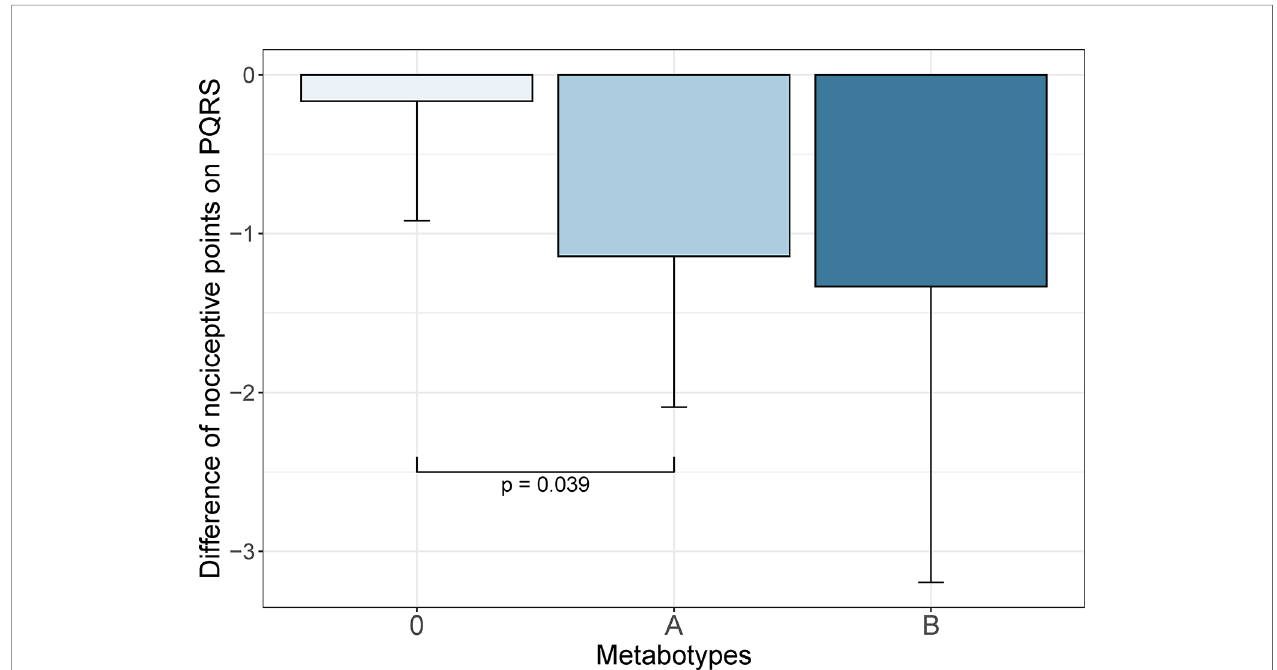
FIGURE 5 | Decline of the nociceptive score points during the post-operative recovery of 26 patients who both completed the Post-operative Quality Recovery Scale (PQRS; [26]) questionnaire and blood samples were available. Based on urolithin metabolic phenotype classi fi ed in serum samples, patients with metabotype A experienced a statistically signi fi cant improvement in the pain score compared to metabotype 0 (p = 0.039). The columns represent means and standard deviation.